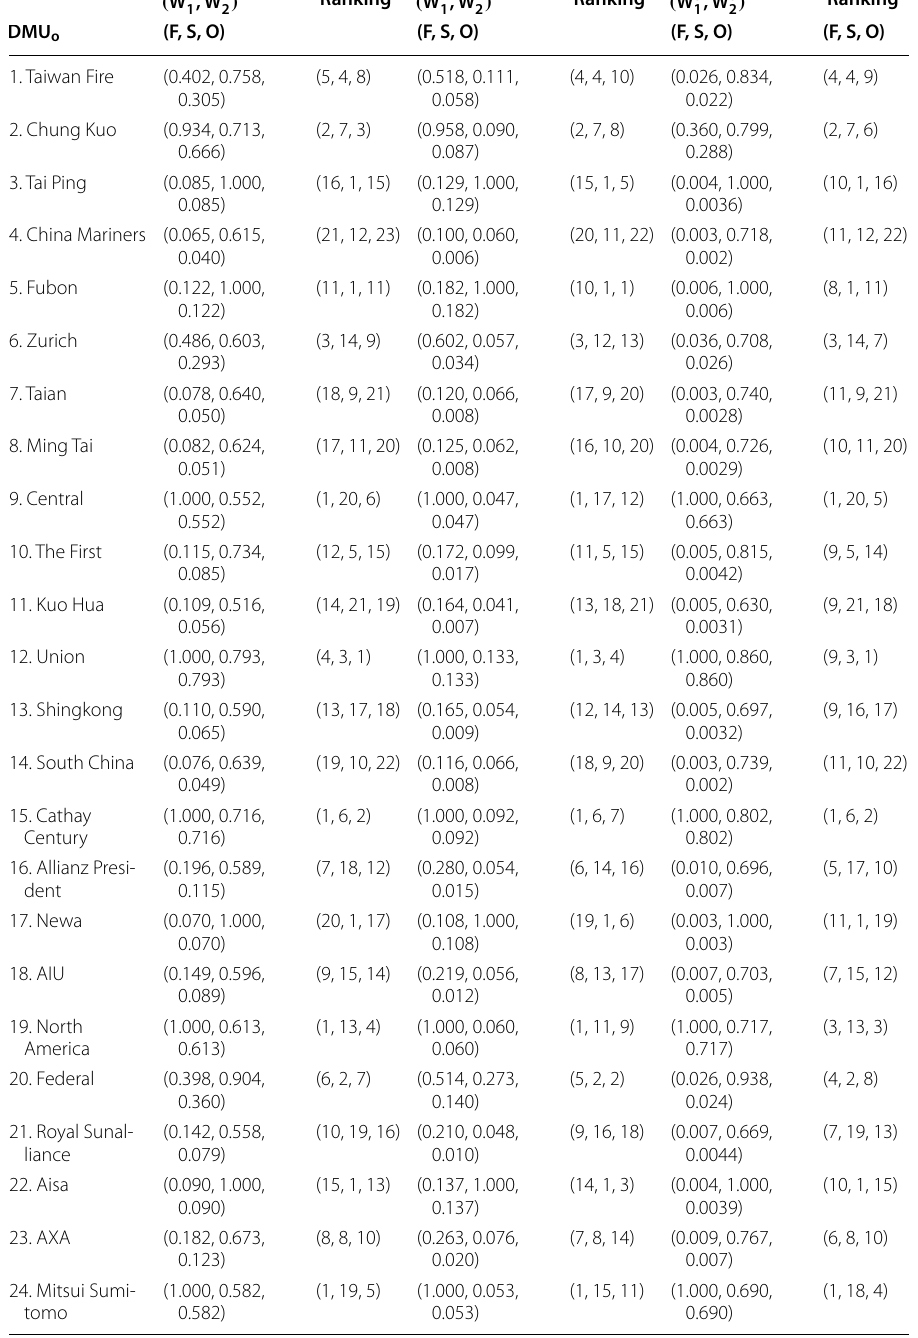
Table 8 Example 3. Results from TND-R model